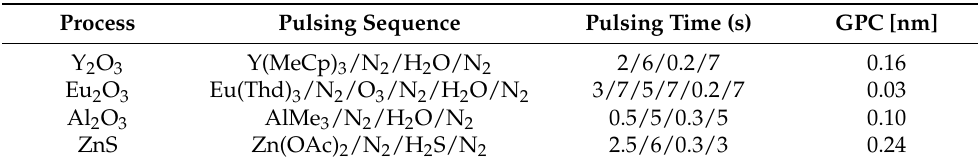
Table 1. Pulsing sequences and corresponding pulse time and purge time for the thin films prepared by atomic layer deposition (ALD). Growth per cycle (GPC) values displayed on the table were deduced from ellipsometry